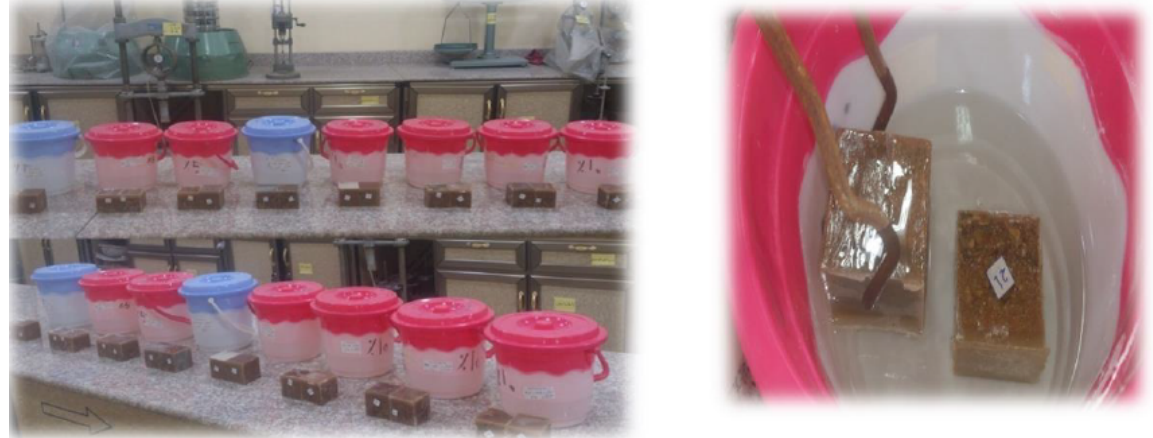
Figure S1: Specimens Submerged at Age 28 in Diluted Solution (5 and 10)% of Sulfuric